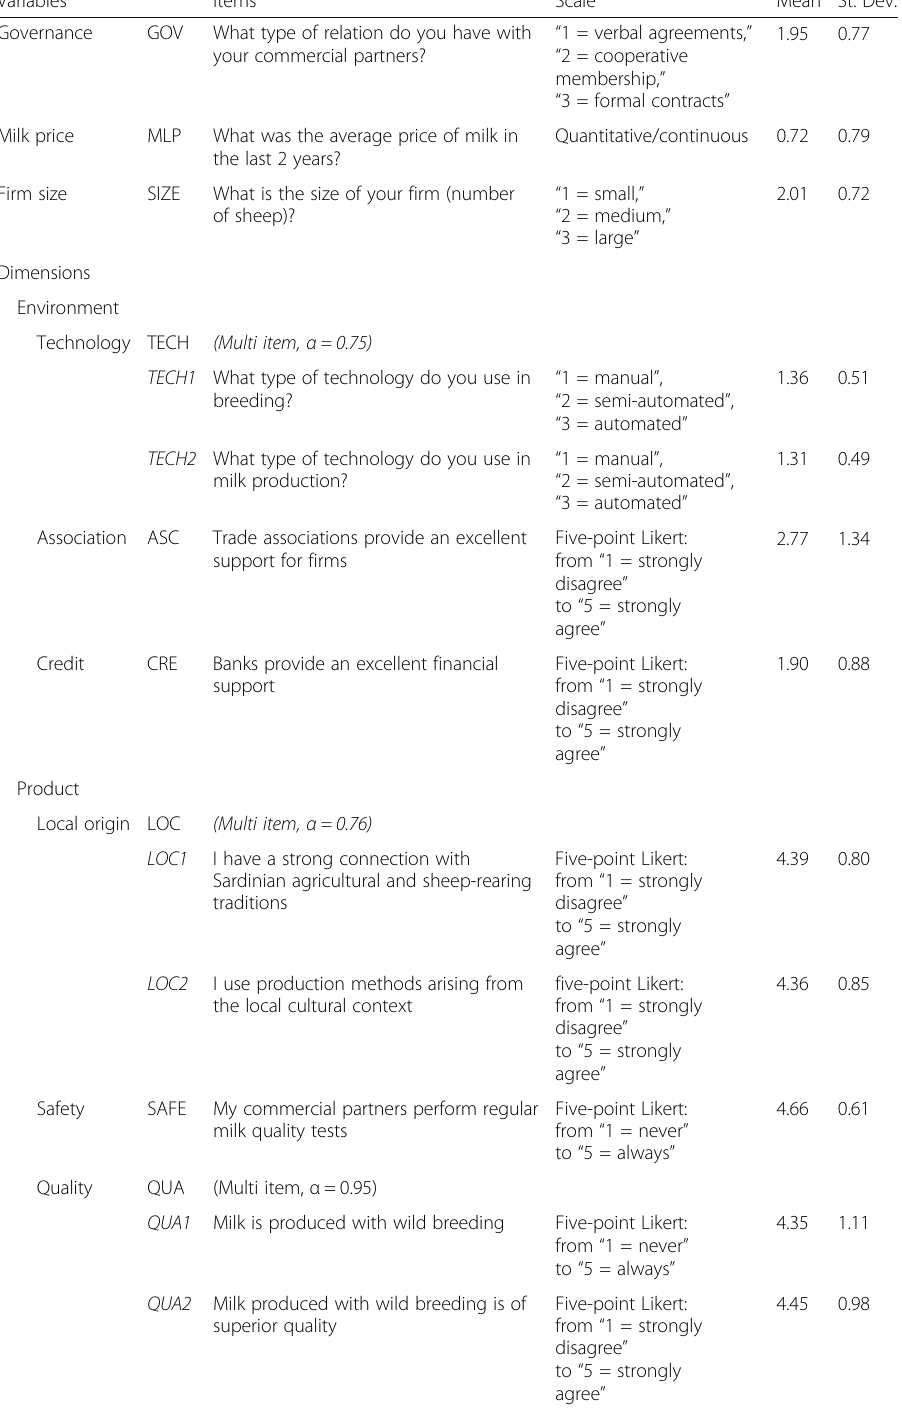
Table 4 Items and scales used in the questionnaire Variables Items Scale Mean St.